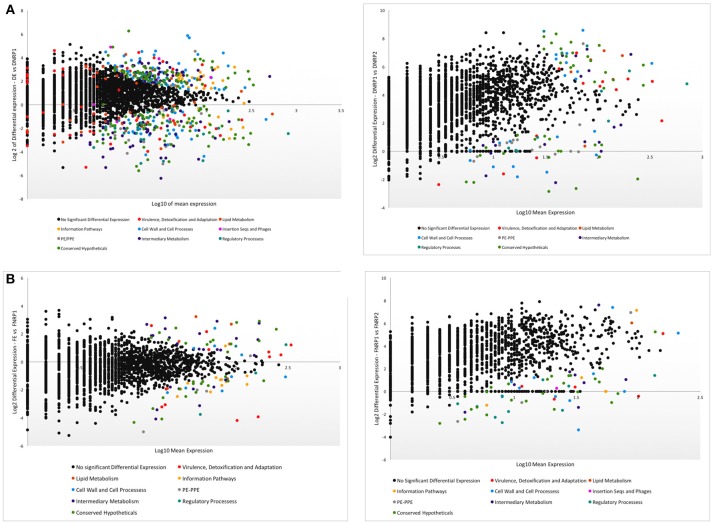
Volcano plots showing the functional categories of genes differentially expressed during the adaptation to hypoxia under different carbon sources. (A) Hypoxia in dextrose as carbon source. Left panel, DE compared to DNRP1; right panel, DNRP1 compared to DNRP2. (B) Hypoxia in LC-FA as carbon source. Left panel, FE compared to FNRP1; right panel, FNRP1 compared to FNRP2.